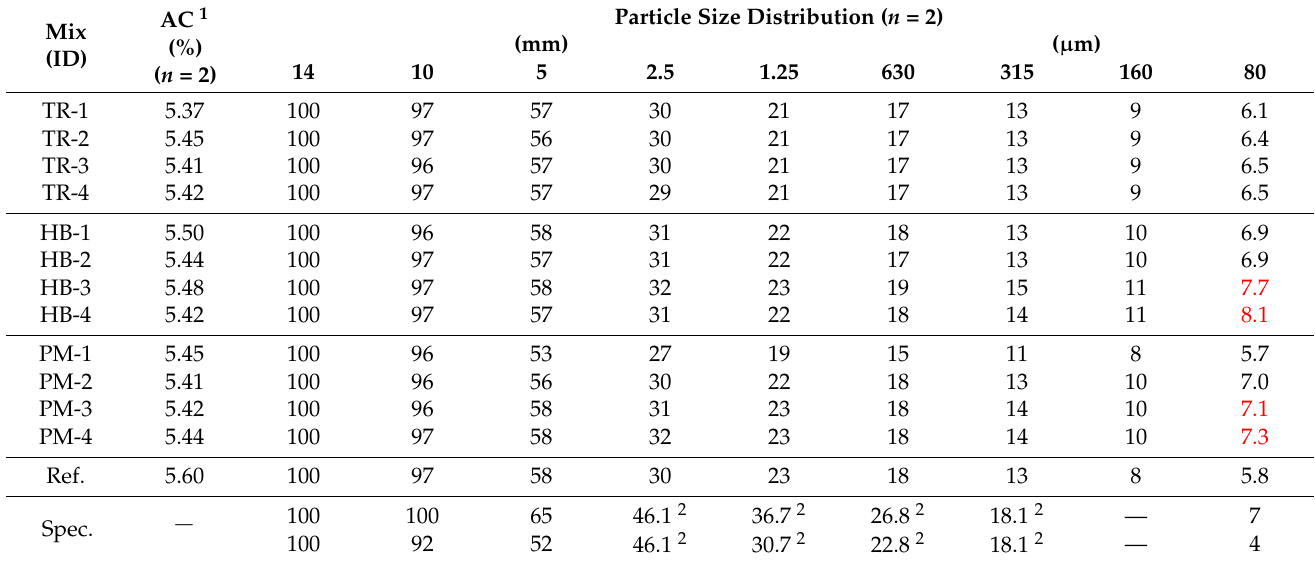
Table 7. Bitumen content and particle size distribution from ignition.